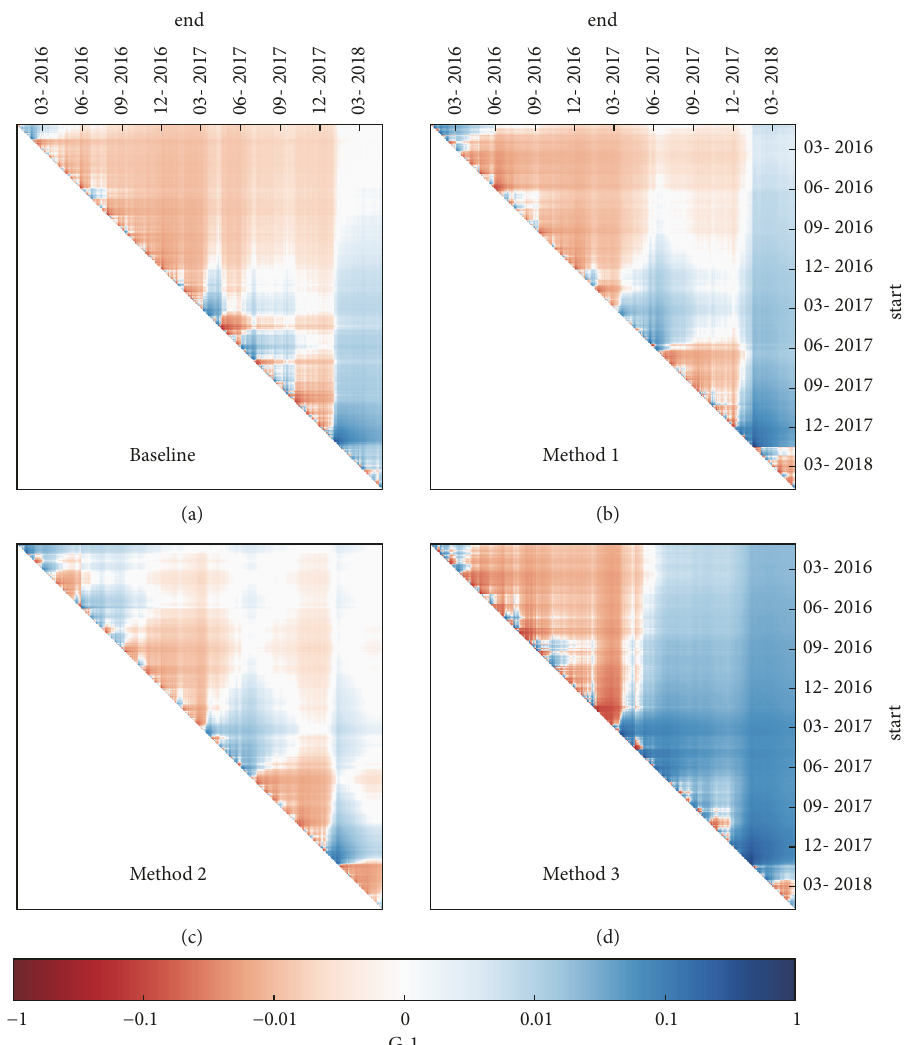
Figure 15: Daily geometric mean return obtained under transaction fees of 0.2 % . The geometric mean return computed between time “start” and “end” using the Sharpe ratio optimisation for the baseline (a), Method 1 (b), Method 2 (c), and Method 3 (d). Note that, for visualization purposes, the figure shows the translated geometric mean return G-1. Shades of red refer to negative returns and shades of blue to positive ones (see colour bar).